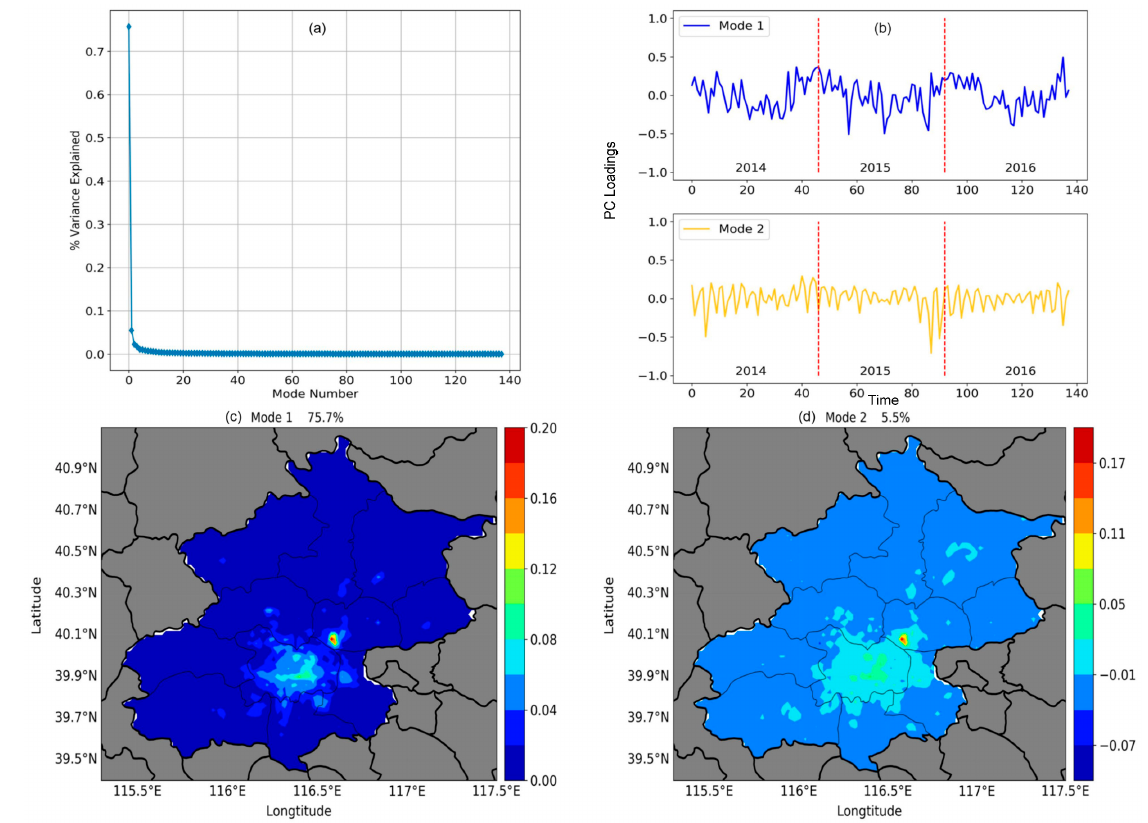
Figure 5. The S-mode PCA results for Beijing DNB data during 2014–2016: ( a ) the variance explained by the principal covariance analysis (PCA) modes for DNB; ( b ) the PC time series for the first two modes (the red vertical lines are used to divide data in different years); ( c , d ) the spatial patterns of the first two modes for the PCA results.